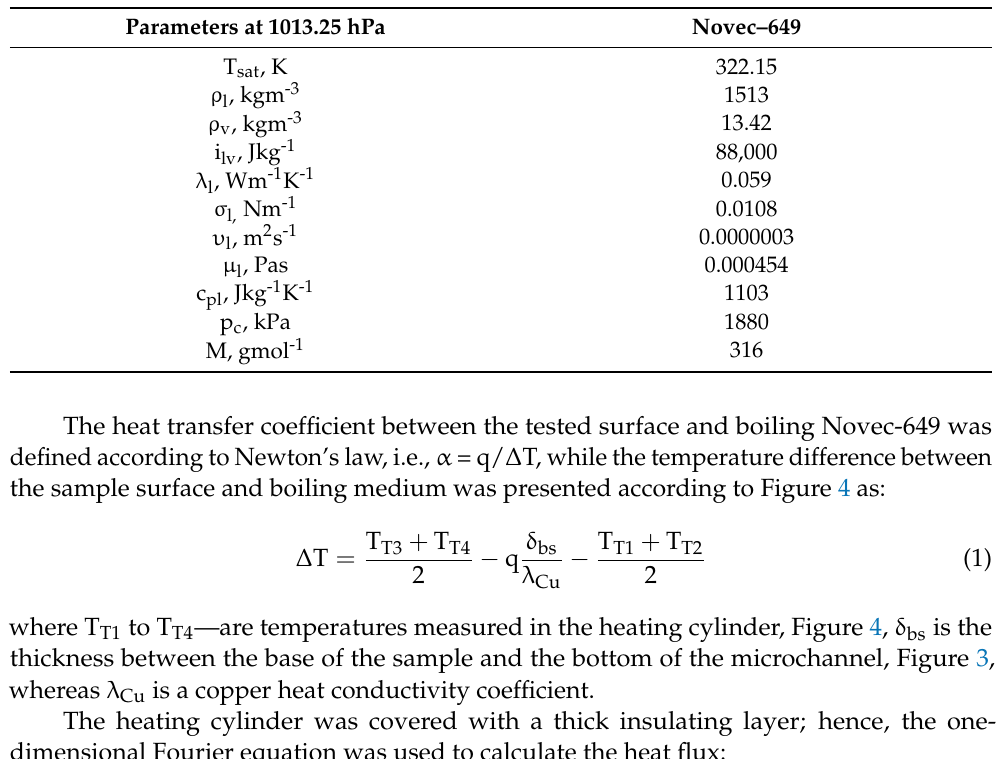
Figure 3. Dimensions of characteristically tested surfaces.